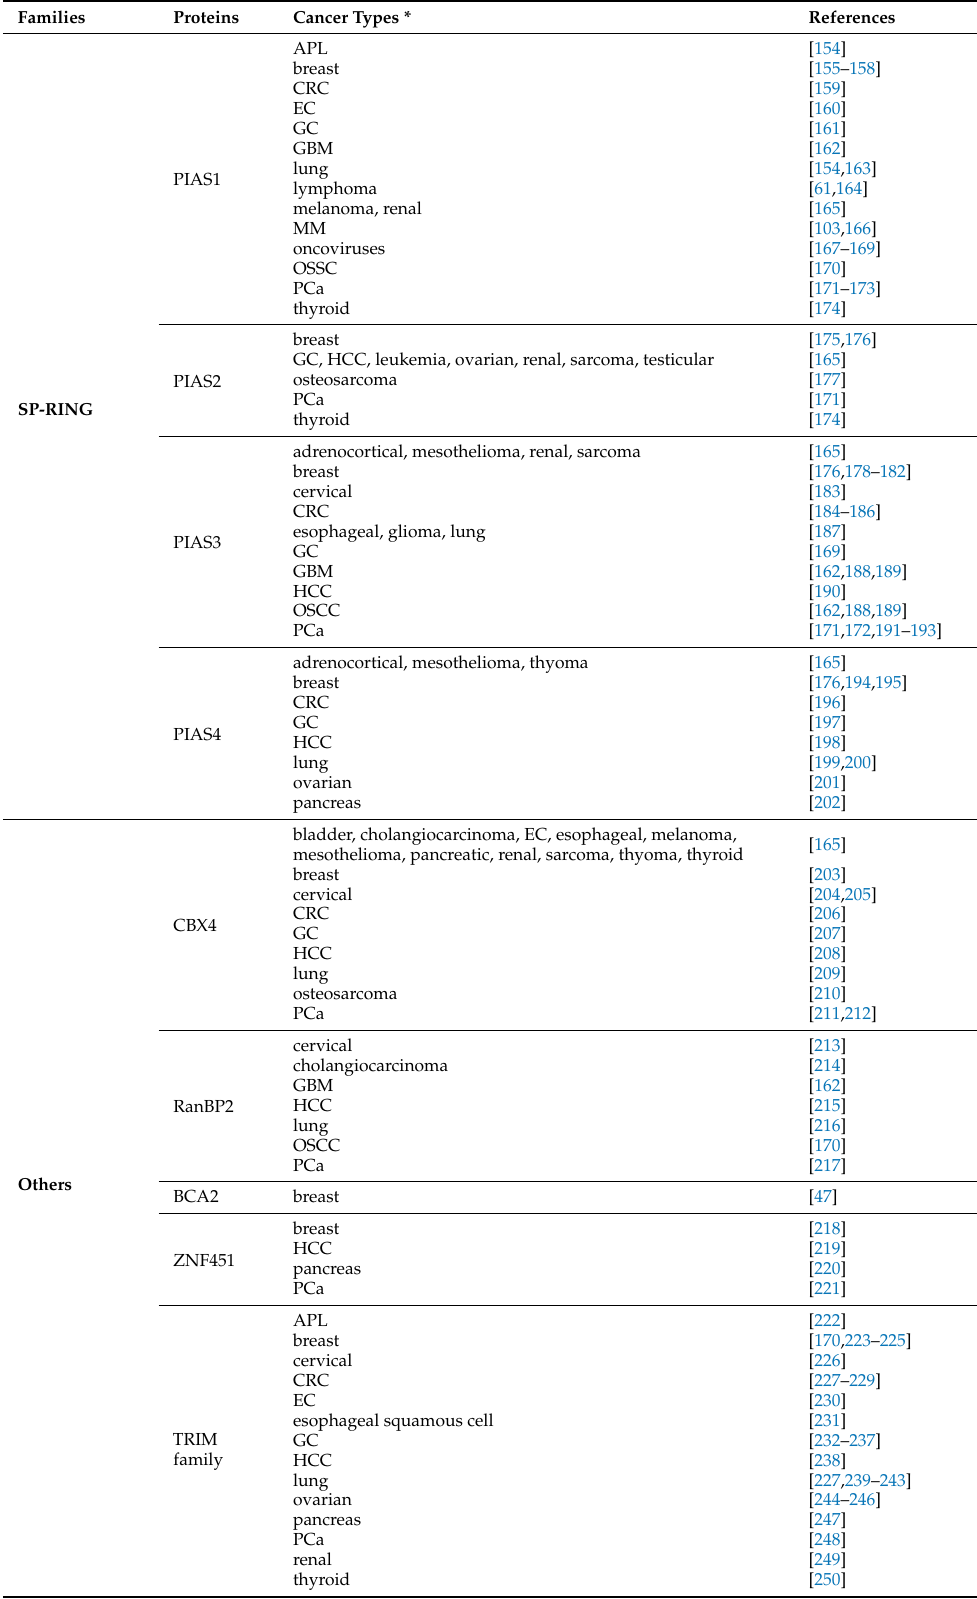
Table 3. SUMO ligases involved in